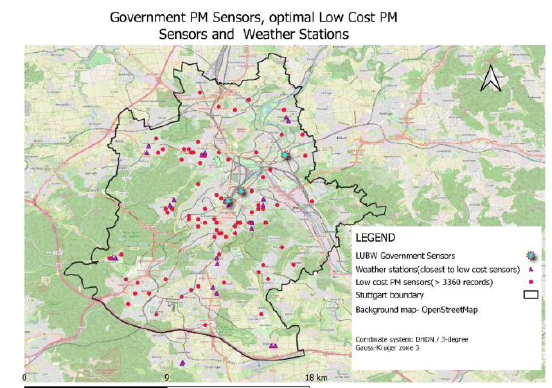
Figure 5. Geographical distribution of the Complete Sensor